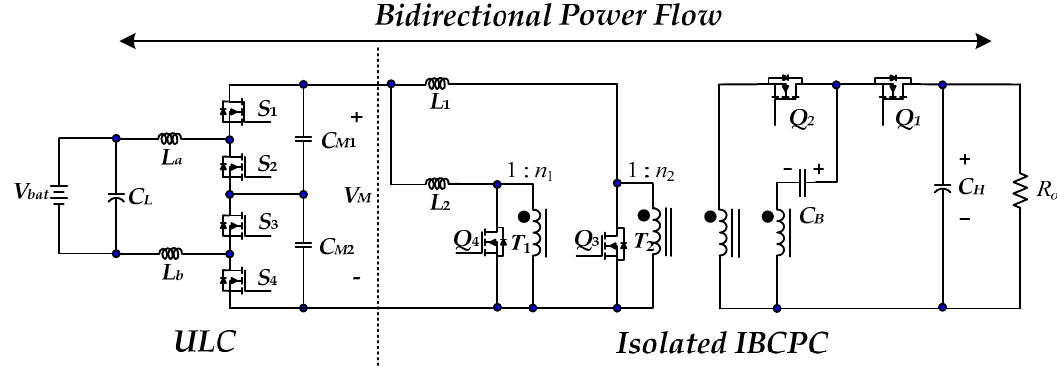
Figure 14. The extended galvanic isolated configuration based on the proposed high-gain RC-BDC for safety insulation requirement and higher voltage conversion ratio applications.